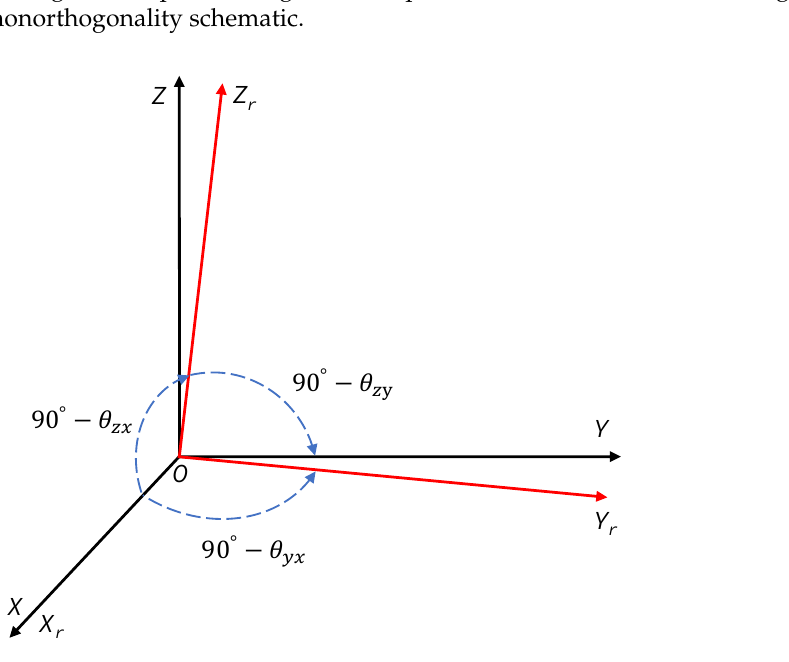
Figure 7. Nonorthogonality schematic. The cross-axis sensitivity of the triaxial accelerometer and gyroscope can be described by the third-order matrix C , as shown in Equation